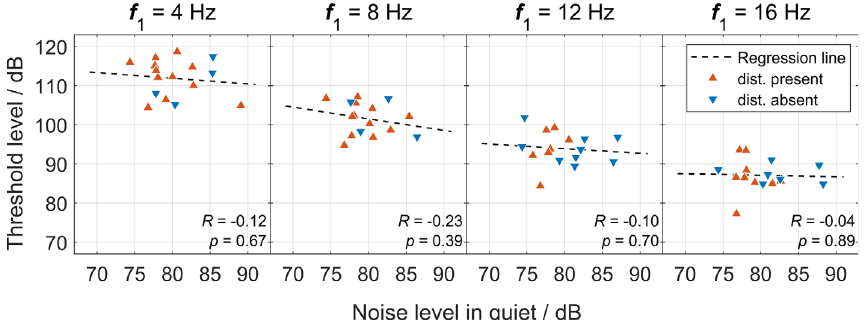
Figure 8. Analysis of correlations between infrasound thresholds and physiological infrasound noise in the ear canal. Each panel shows the analysis for one of the four infrasound frequencies. Each triangle represents the data of one of the 16 listeners. Colors and symbols indicate the absence (blue, downward-pointing triangles) or presence (red, upward-pointing triangles) of ear-generated distortion products at any higher harmonic from f 2 to f 9 of the signal frequency f 1 . To quantify physiological infrasound noise, the average spectrum (average of fi ve) was measured in quiet and integrated from 2 Hz to 20 Hz. The integrated power is expressed in